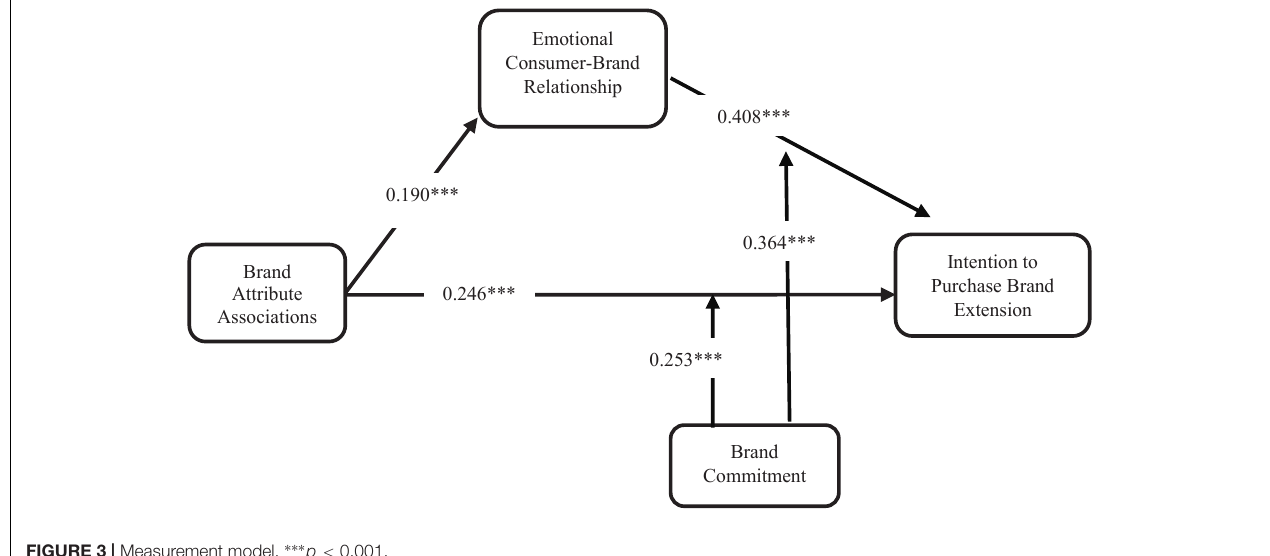
FIGURE 3 | Measurement model. ∗∗∗ p < 0.001. TABLE 4 | Structural model results effects.